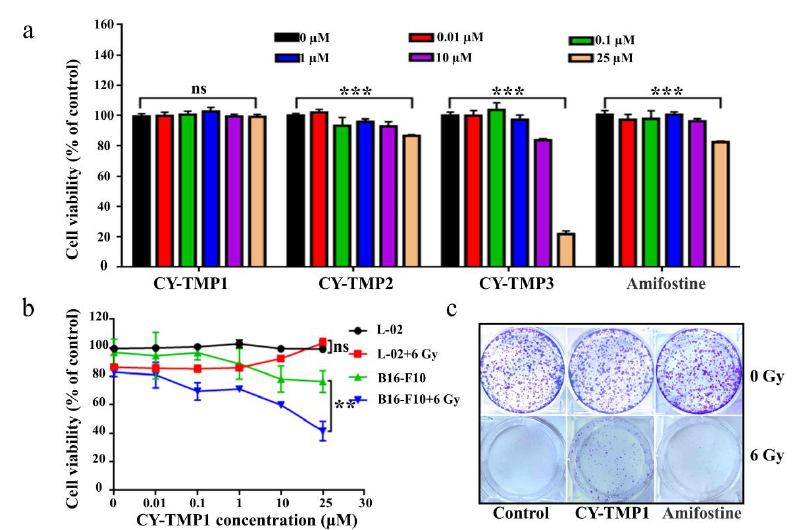
Figure 1. In vitro radioprotective effects evaluation of CY-TMP conjugates. ( a ) Cytotoxicity evaluation of CY-TMP1, CY-TMP2, CY-TMP3 and Amifostine on L-02 cells. “***” represents significant difference from 0 μM group, “ns” represents no significance. *** p < 0.001, Data are expressed as Mean ± SD ( n = 3). ( b ) Radioprotective effect of CY-TMP1 on normal cells (L-02) and cancer cells (B16-F10). CY-TMP1 selectively protects normal cells rather than cancer cells from ionizing radiation injury. Comparison of cell viability after treatment with CY-TMP1 (25 µ M) between radiation and